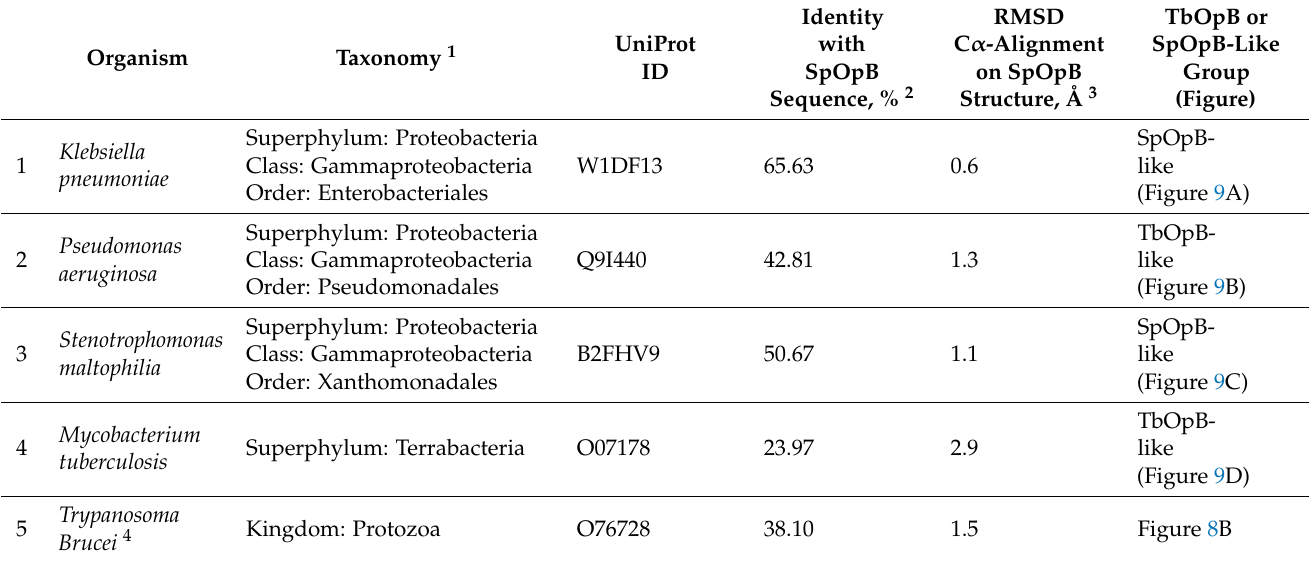
Table 4. Characteristics of four bacterial OpBs from causative agents of nosocomial infections belonging to the SpOpB- and TbOpB-like